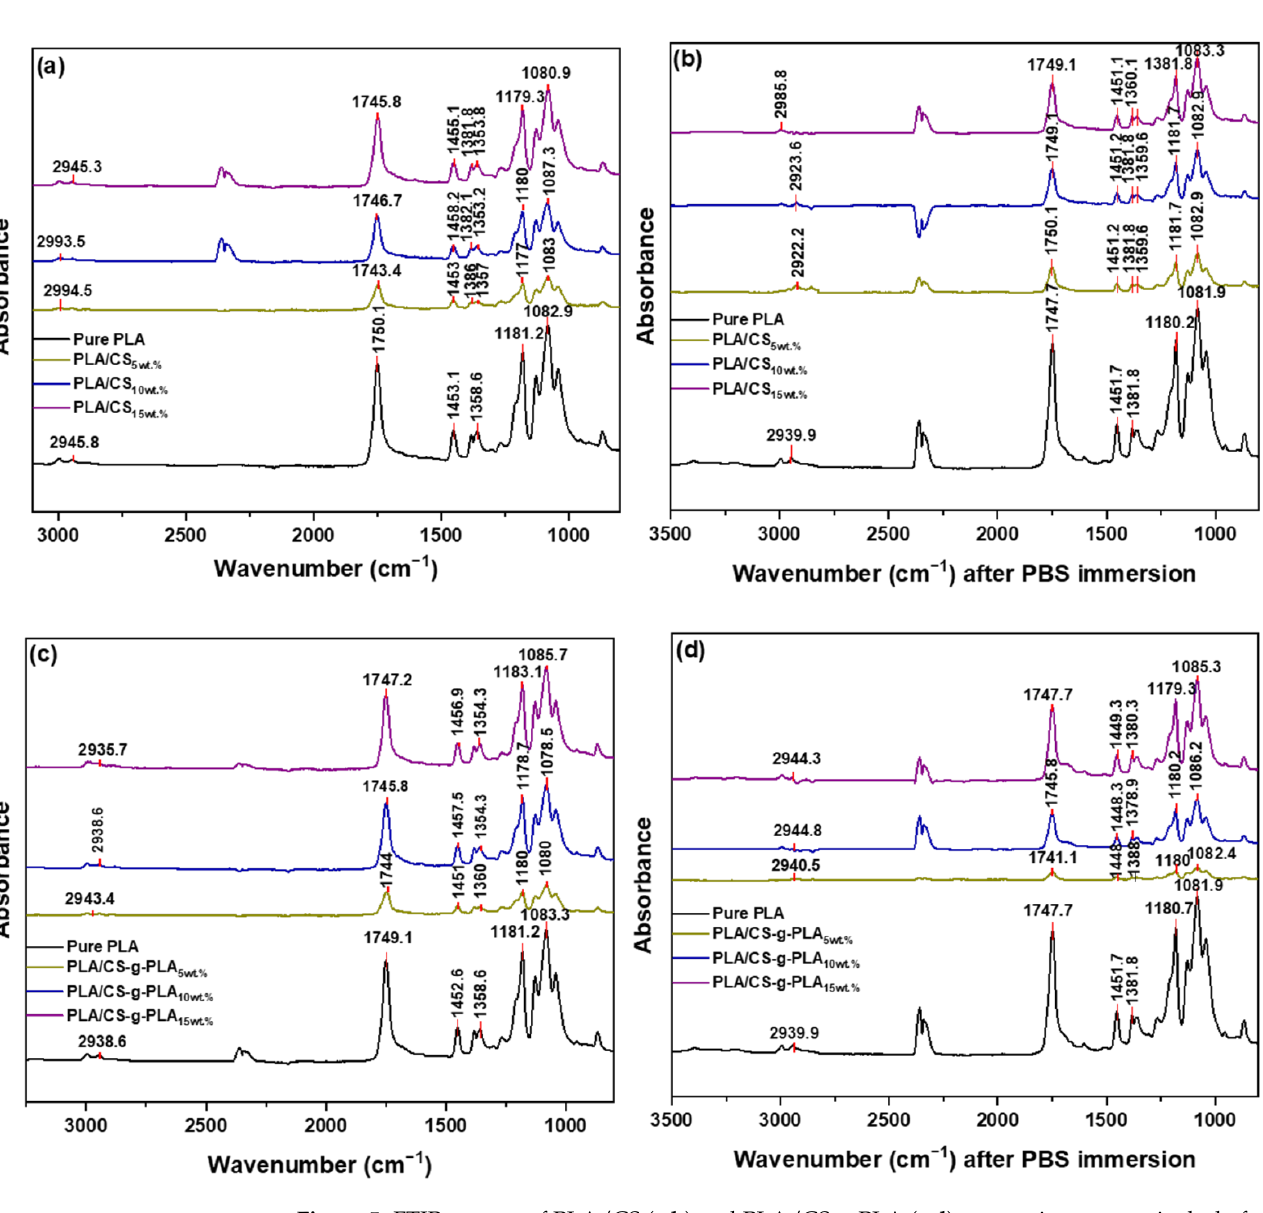
Figure 5. FTIR spectra of PLA/CS ( a , b ) and PLA/CS-g-PLA ( c , d ) composites, respectively, before and after their immersion in PBS